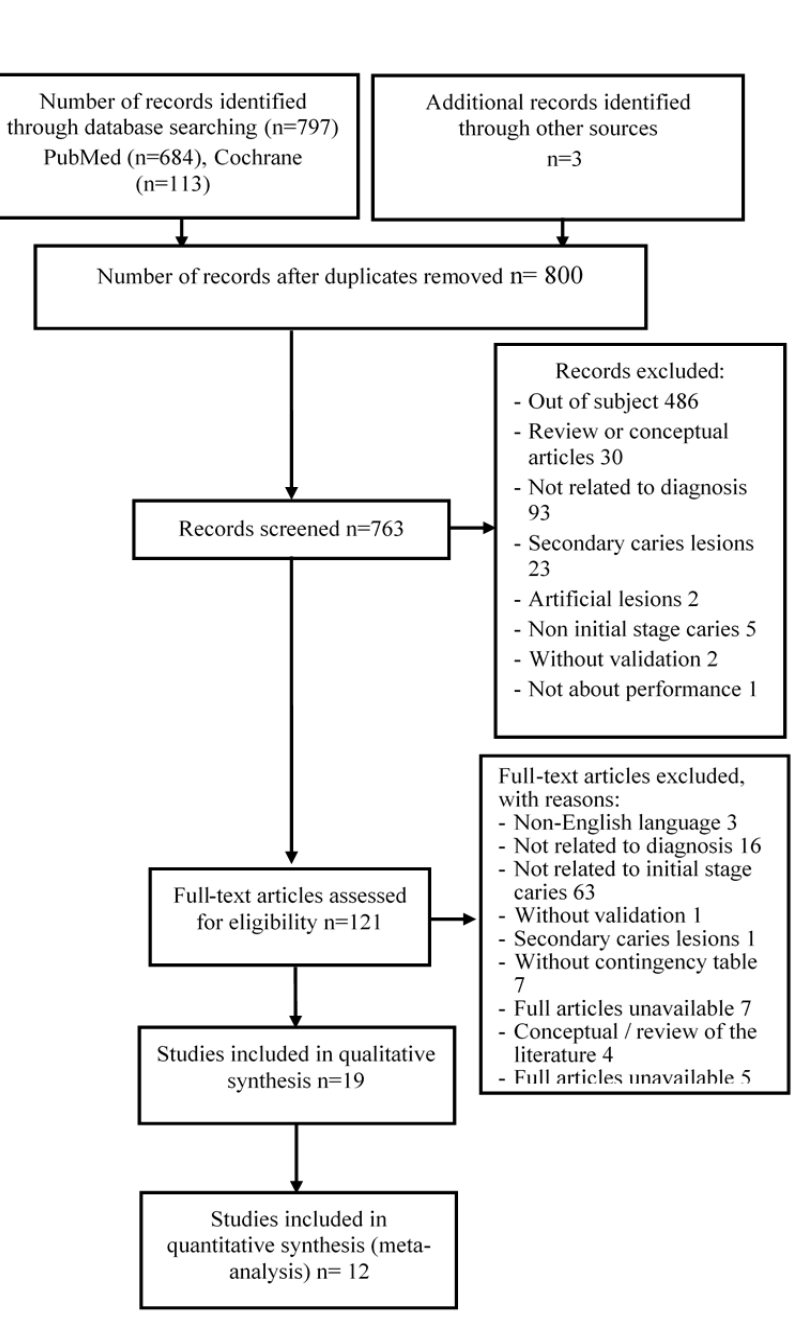
Figure 1. Flow chart of study selection